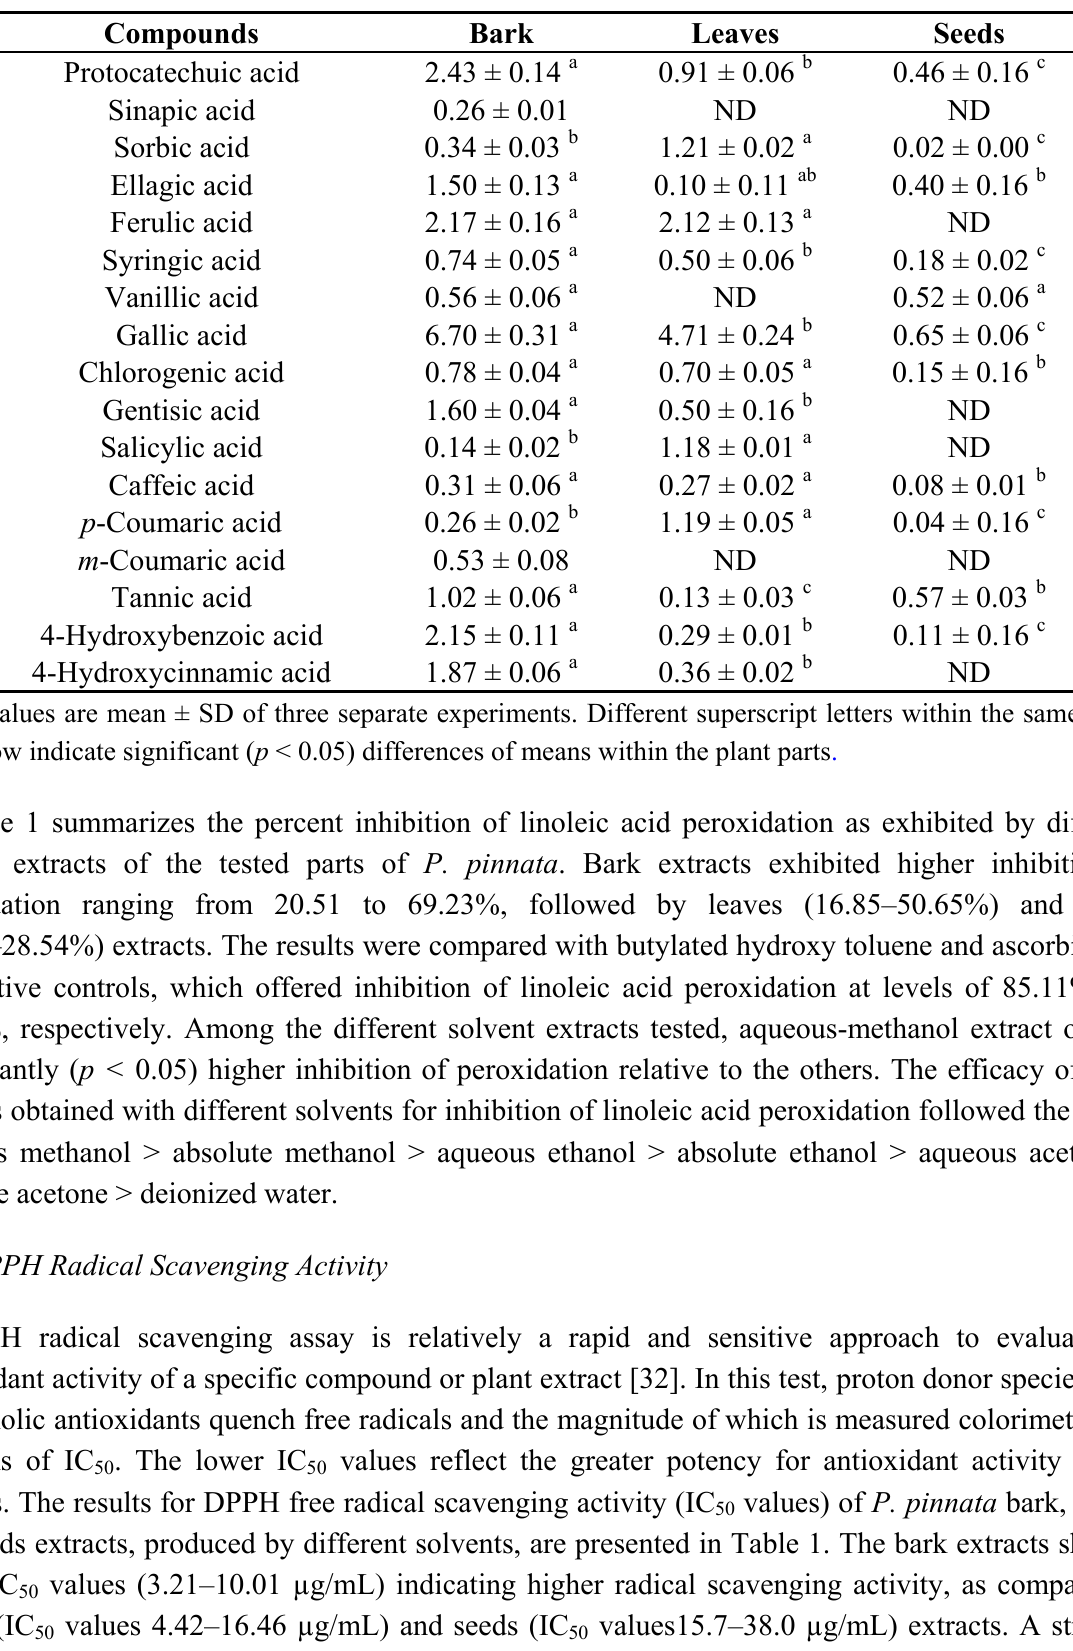
Table 2. HPLC quantification of aqueous-methanol soluble phenolic components (mg/100 g DW) identified in different parts of P. pinnata